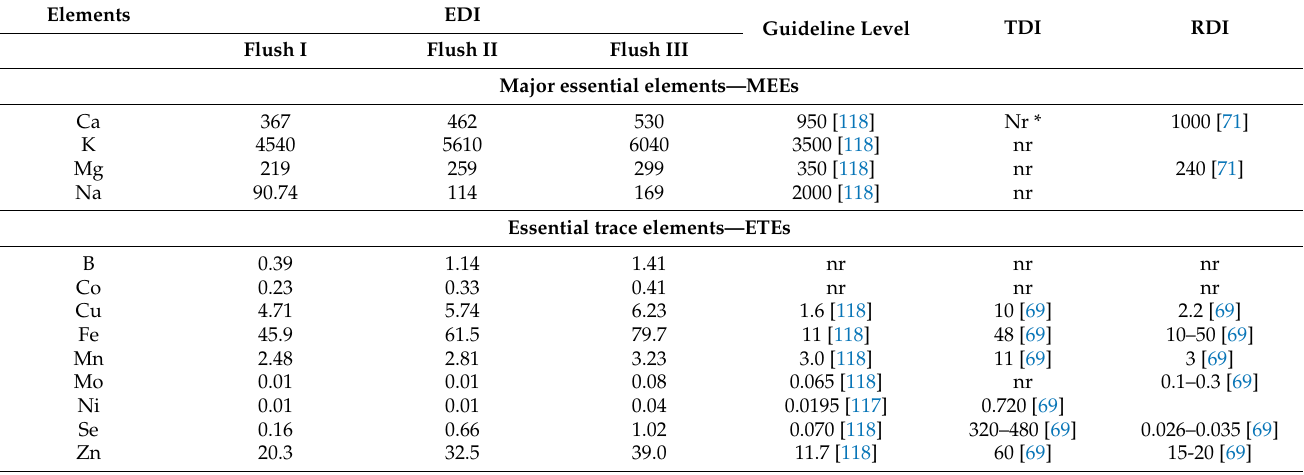
Table 7. Estimated daily intake (EDI, mg · kg − 1 d − 1 ) of major essential elements (MEEs), essential trace elements (ETEs), trace elements with detrimental health effect (TEWDHE) and nutritionally nonessential elements (NNEs) through the consumption of one serving (calculated as 250 g F.W., corresponding to 25 g D.W.) of P. djamor mushrooms by an adult person (60 kg). TDI—tolerance